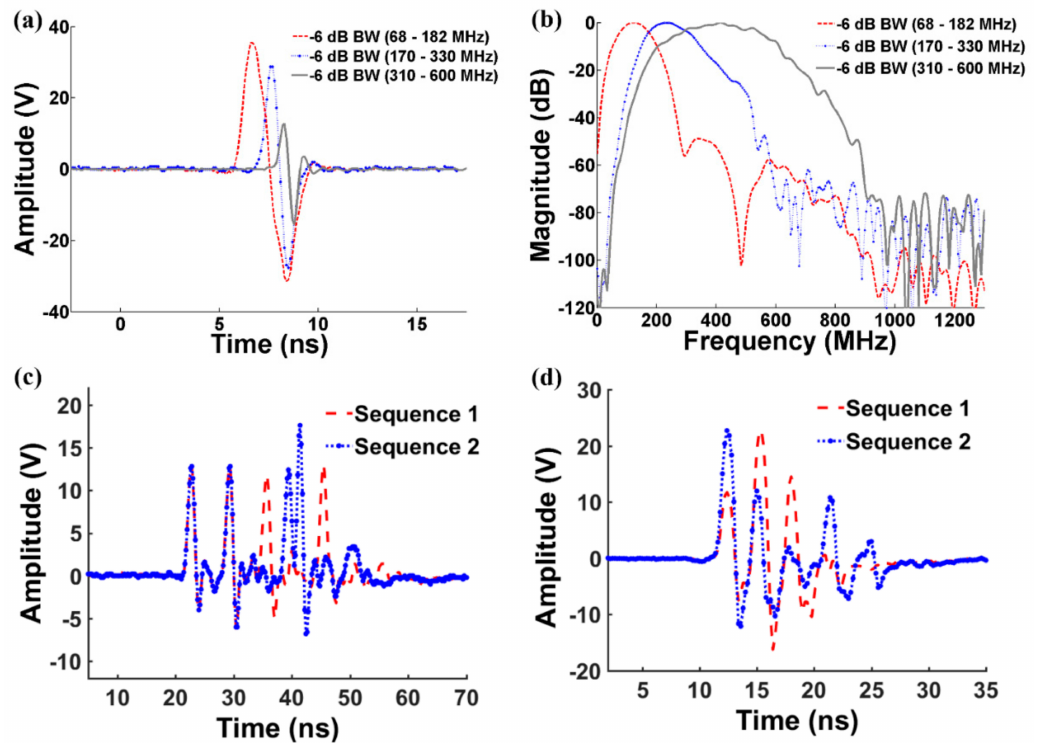
Figure 4. Measured output pulses from the proposed transmitter: ( a ) Output pulses in the time domain; ( b ) output pulses in the frequency domain; ( c ) four-bit 156 MHz unipolar pseudo Golay codes from the combined pulse generators; and ( d ) four-bit 312 MHz bipolar pseudo Golay codes from the combined pulse